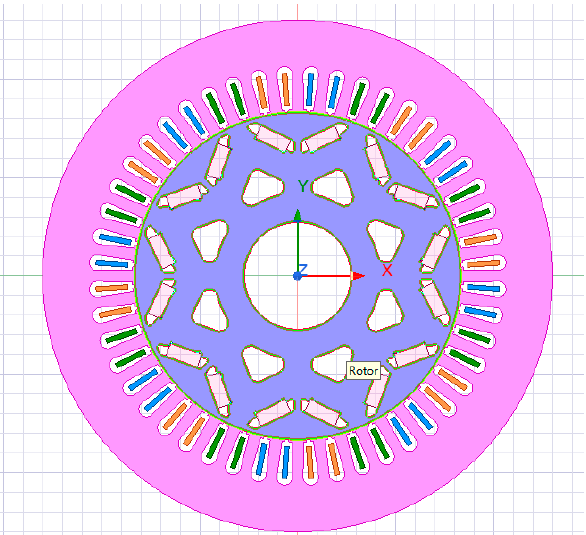
Figure 2. 2D diagram of motor. Table 1. Dimensional parameters of PMSM.